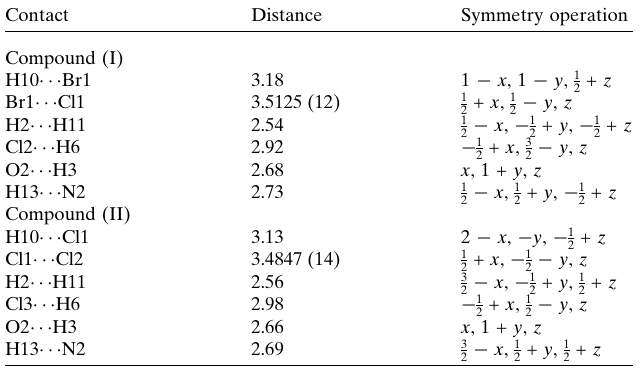
Table 3 Summary of short interatomic contacts (A˚ ) in the crystal structures of compounds (I) and (II).